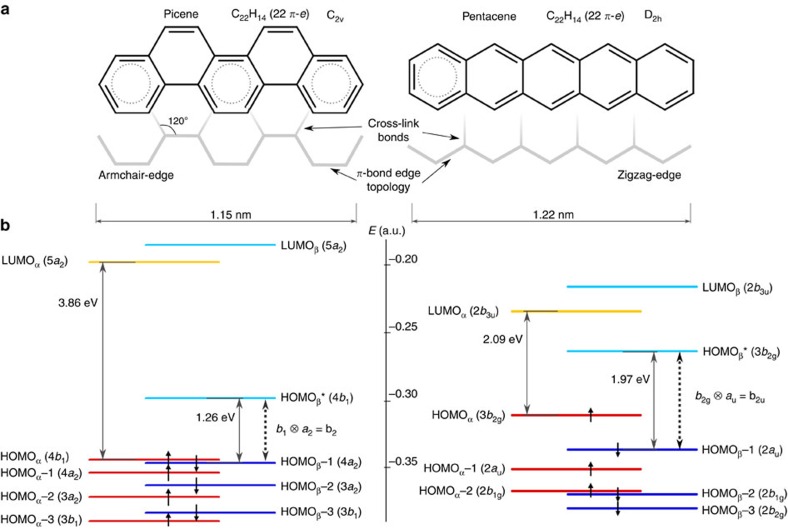
Investigated monomers and frontier π spin-orbital energy levels.(a) Chemical structures of picene (D2h symmetry) and pentacene (C2v symmetry) featuring delocalized sextet rings of six π-electrons (dotted inner circles). (b) Energy-level configurations of molecular π spin-orbitals in the cationic spin-doublet ground state (B3LYP/6-311G**). The energy gaps between spin-orbitals are governed by cross-link bond electrostatic interactions19. The vertical cross-link bonding between two zigzag edges causes out-of-phase atomic-orbital combinations32 that tend to disperse frontier spin-orbitals, while the interaction between armchair edges takes place through inner ca. 120° angle-oriented cross-linkage of in-phase character, resulting in spin-orbitals that bear close proximity or even accidental degeneracy. Dotted arrows show main vibronically active π→π* orbital excitations along b2 (picene+) and b2u (pentacene+) symmetry modes. LUMO stands for lowest-unoccupied molecular orbital and 1 energy atomic unit (a.u.) is 27.21 eV.